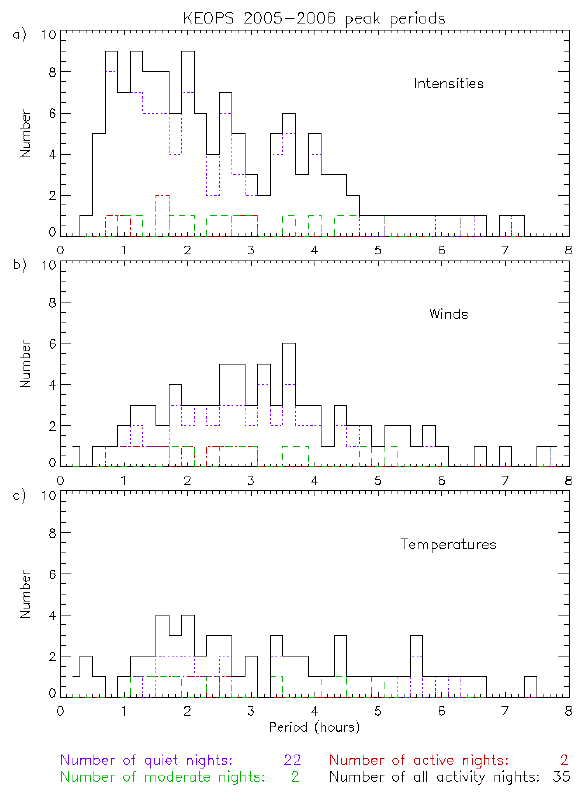
Fig. 4. Histogram of gravity wave periods for all nights and all ac- tivity levels, from KEOPS data over the winter season of 2005–2006 (solar minimum): (a) intensities, (b) winds, and (c) temperatures. which is just due to the sky becoming overcast at this